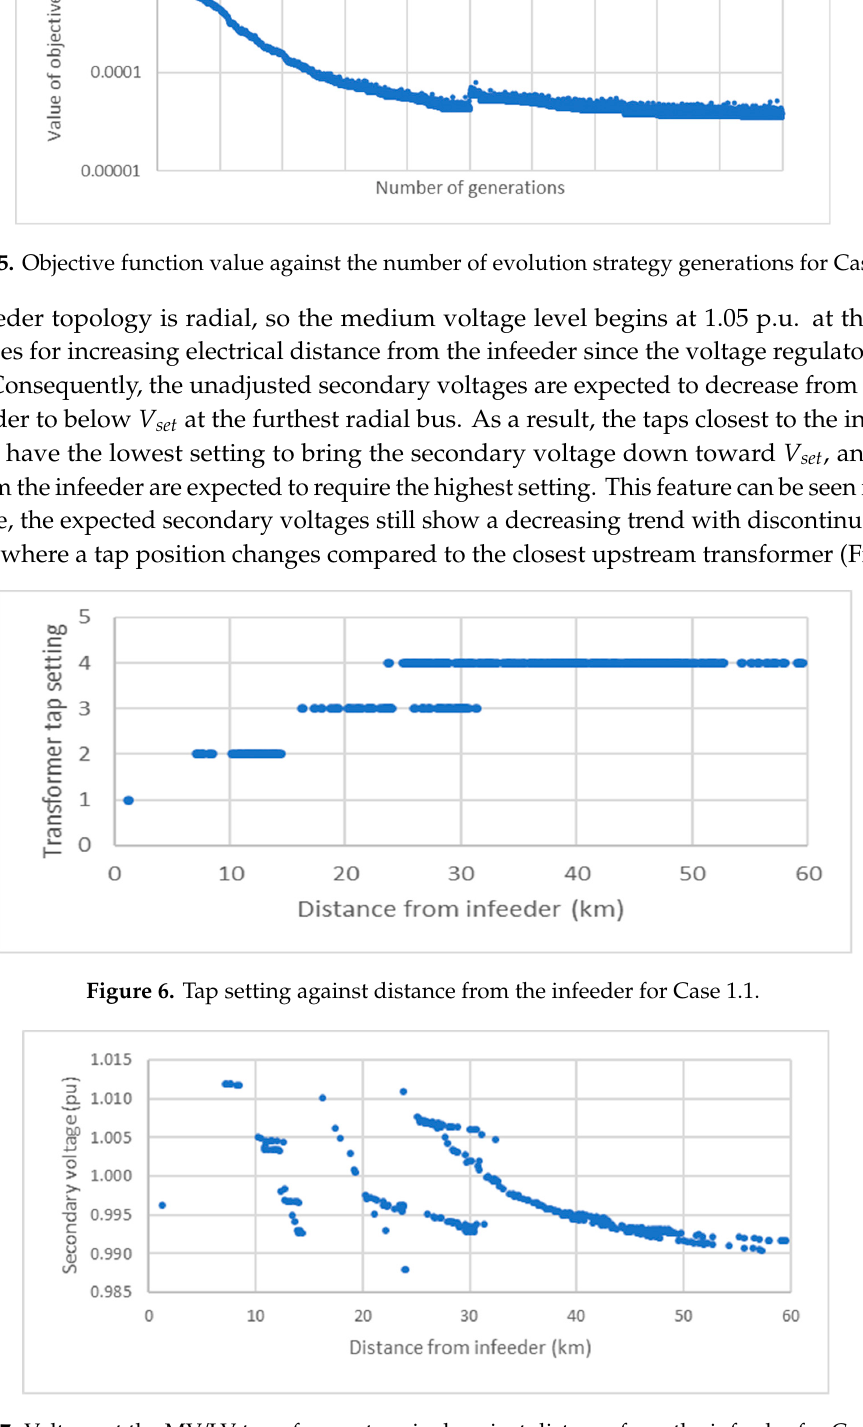
Figure 7. Voltage at the MV/LV transformer terminal against distance from the infeeder for Case 1.1.